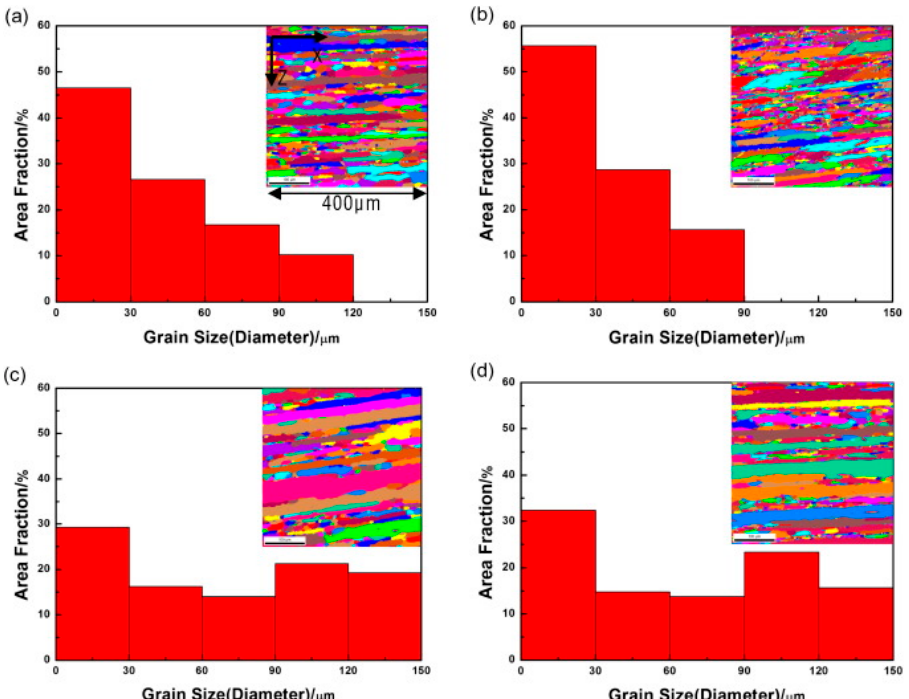
Figure 10. Grain size distribution of A7N01S-T5 alloys with different compositions: ( a ) #1, ( b ) #2, ( c ) #3 and ( d ) #4 [46]. Table 2. Elemental composition of tested A7N01S-T5 alloys (wt.%) [46].